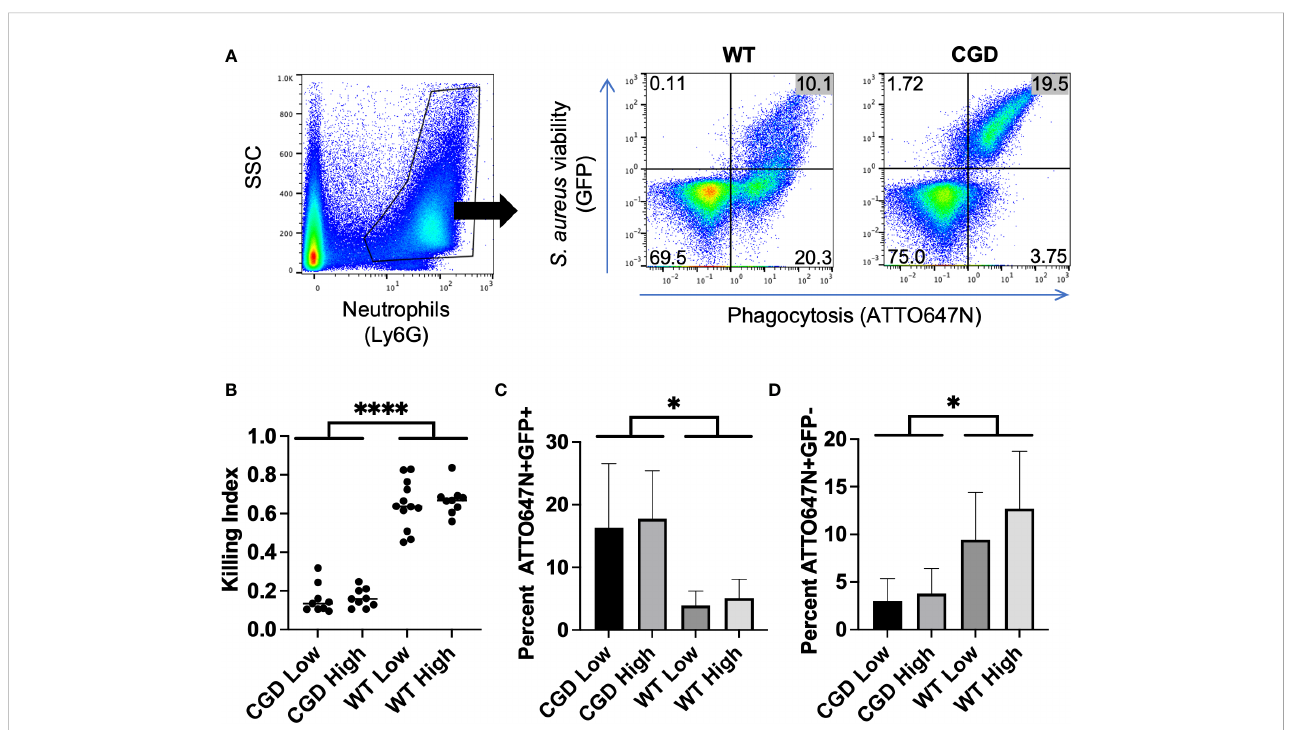
FIGURE 4 BAL from WT and CGD animals infected with bi- fl uorescent S. aureus. (A) Gating on Ly6G + events within the BAL enables the separation of neutrophils based on GFP and ATTO647N fl uorescence. (B) The ratio of ATTO647N + GFP - cells to all ATTO647N + cells represents the neutrophils that have completely killed the S. aureus compared to those which have undergone phagocytosis: the killing index. (C) Percent of neutrophils that are ATTO647N + GFP + indicated the intracellular burden of viable S. aureus . (D) Percent of neutrophils that are ATTO647N + GFP - indicates the population of cells that have completed killing (n=8-11 animals per group, from 7 independent experiments). * for p<0.05 and **** for